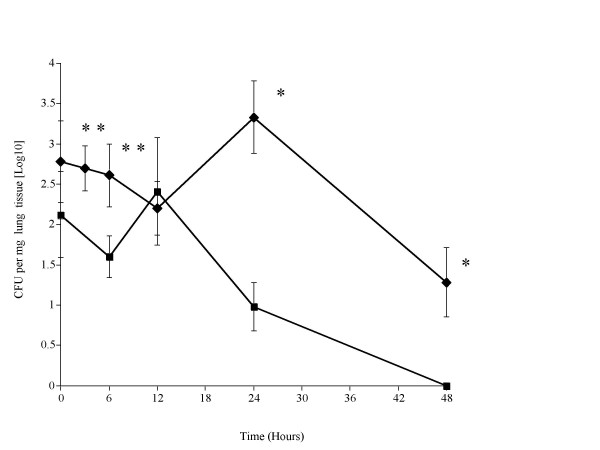
Time course of the change in numbers of S. pneumoniae in the nasopharynx (figure 1), trachea (figure 2), lungs (figure 3) and blood (figure 4) of SP-D-/- (◆) and SP-D+/+ (■) mice infected intranasally with 106 CFU (n = 10 mice at each time point, error bars indicate SEM). * denotes P < 0.01, ** denotes P < 0.05 for SP-D-/- when compared to wildtype at equivalent time point.